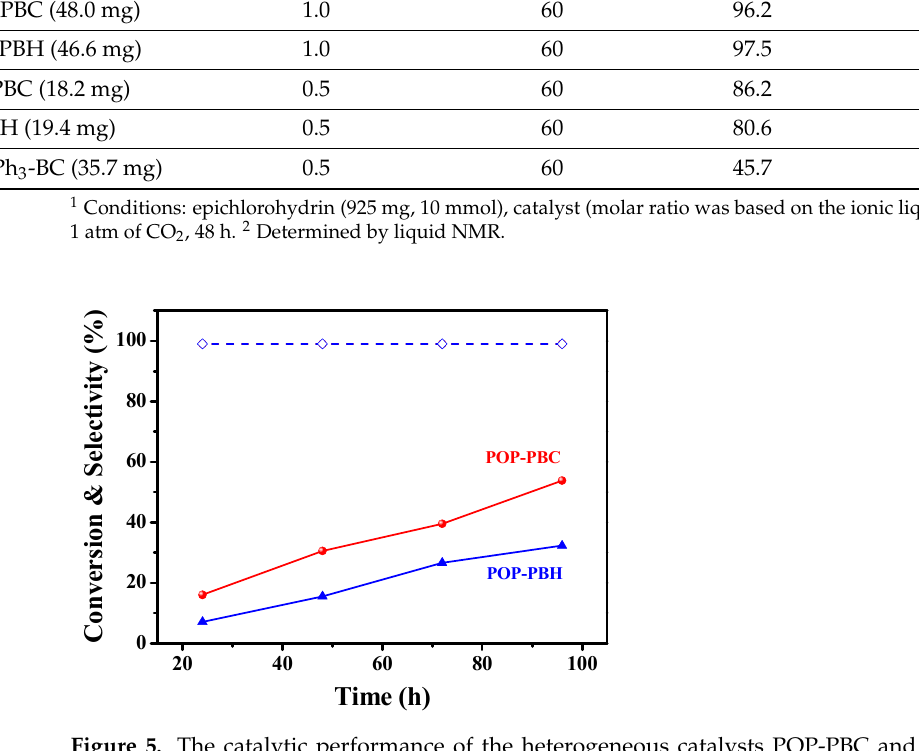
Figure 5. The catalytic performance of the heterogeneous catalysts POP-PBC and POP-PBH in the cycloaddition of CO 2 with epoxide under low CO 2 concentration (15% CO 2 and 85% N 2 , v / v ) condition. Reaction conditions: epichlorohydrin (925 mg, 10 mmol), 1.0 mol.% of catalysts were used under low CO 2 concentration (15% CO 2 and 85% N 2 , v / v ) condition at 333 K for 96 h.